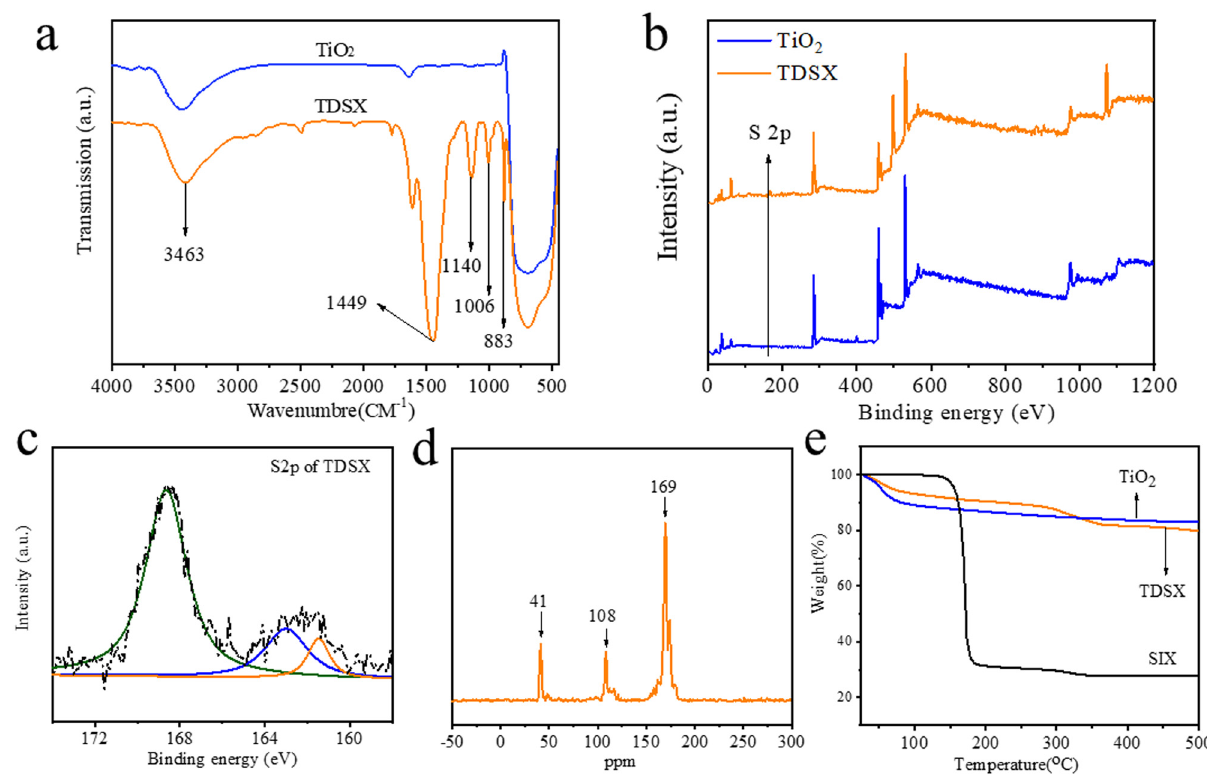
Figure 2: ( a ) FTIR spectra of TiO 2 nanoparticles and TDSX; ( b ) XPS spectra of TiO 2 nanoparticles and TDSX; ( c ) the high - resolution XPS spectra of TDSX; ( d ) 13 C MAS NMR spectra; ( e ) TG curves of TiO 2 nanoparticles and TDSX and sodium isobutyl xanthate.